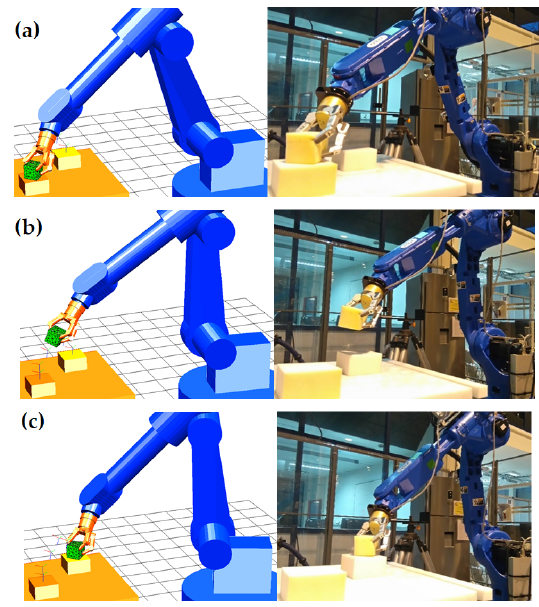
Figure 11. Pick-and-place of the cube by the Adept robot and the Barrett hand: ( a ) grasping, ( b ) lifting, and ( c ) leaving.